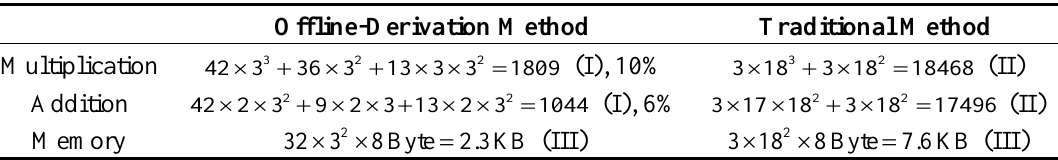
 updating process. n